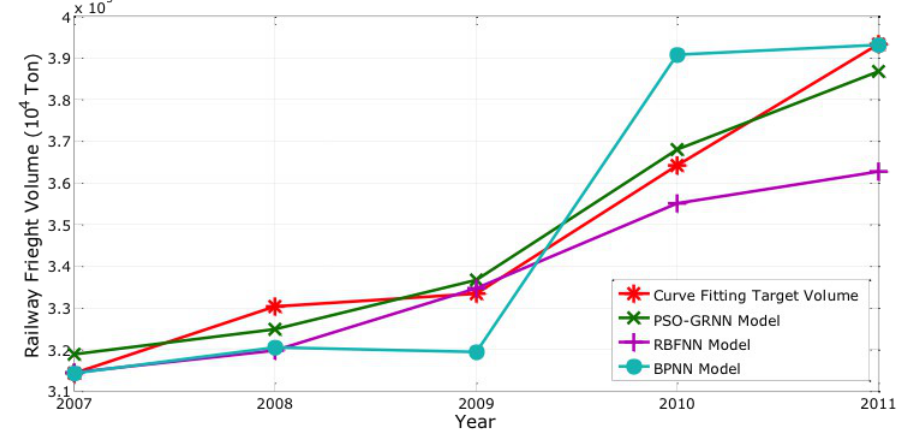
Figure 7. Curve fitting for the target volumes of the three prediction